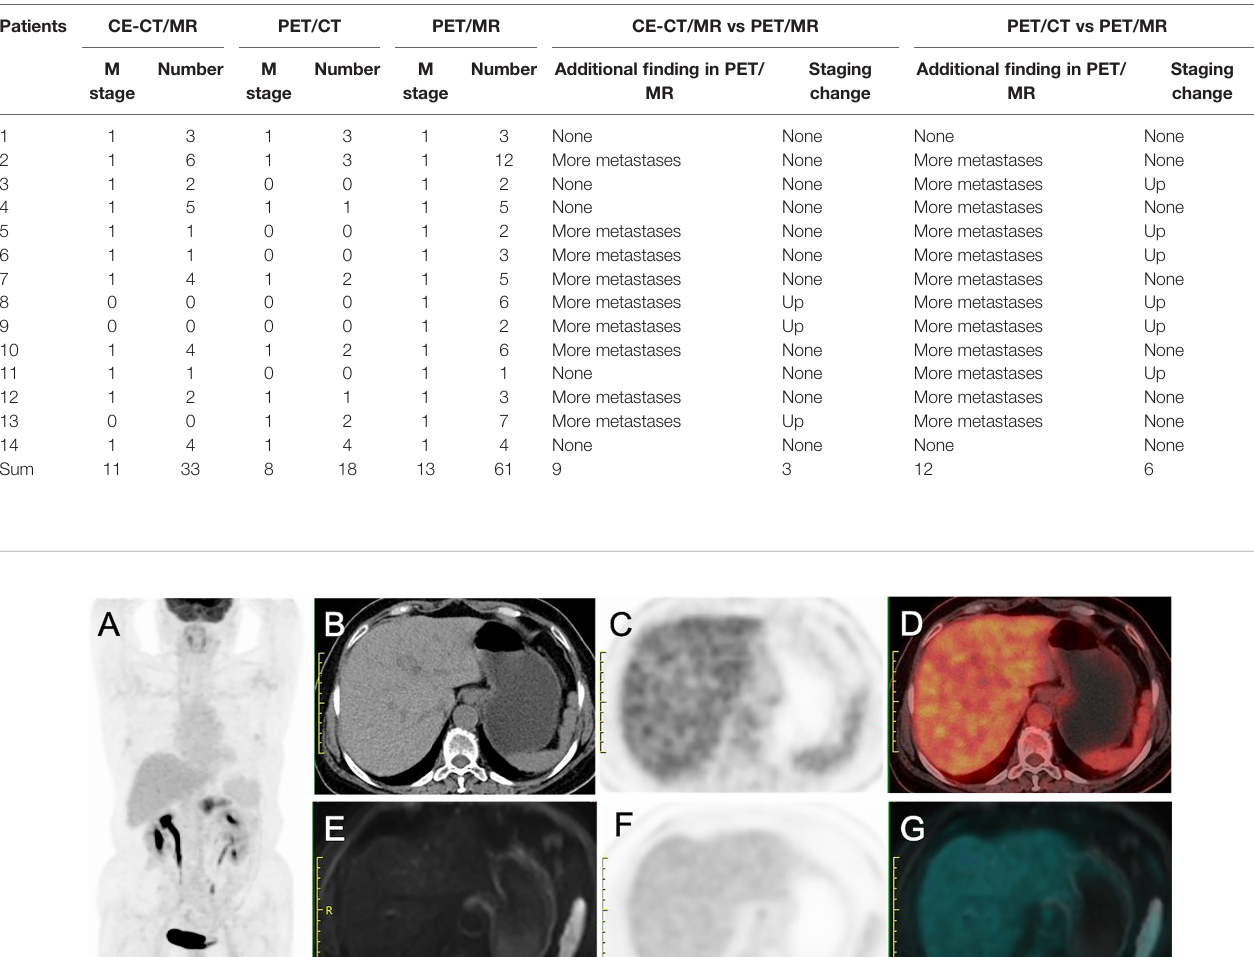
TABLE 4 | Diagnostic performance of PET/CT plus delayed PET/MR imaging and CE-CT/MR imaging in the detection of liver metastases. Patients